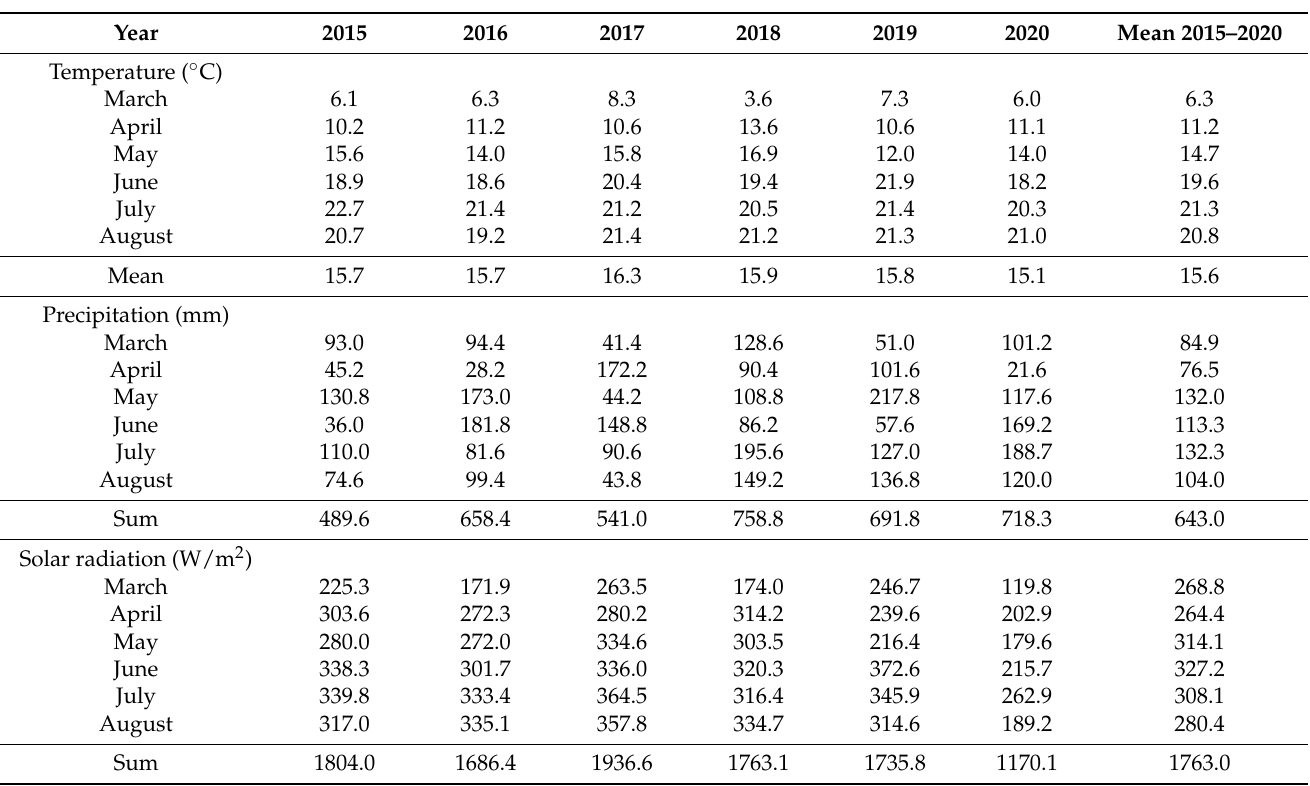
Table 6. Mean daily air temperature and cumulative monthly precipitation from sowing to harvest